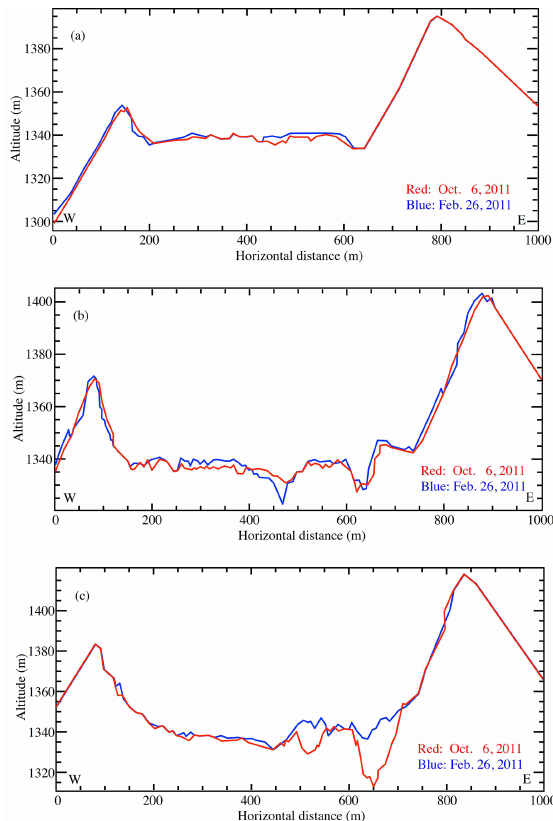
Figure 19. Vertical cross sections inside the caldera of the Shinmoe- dake volcano along the lines (a) , (b ) and (c) , respectively, in Fig. 18 on 6 October 2011 (red) and 26 February 2011 (blue) by airborne SAR (Pi-SAR2) measurements (Kobayashi et al.,